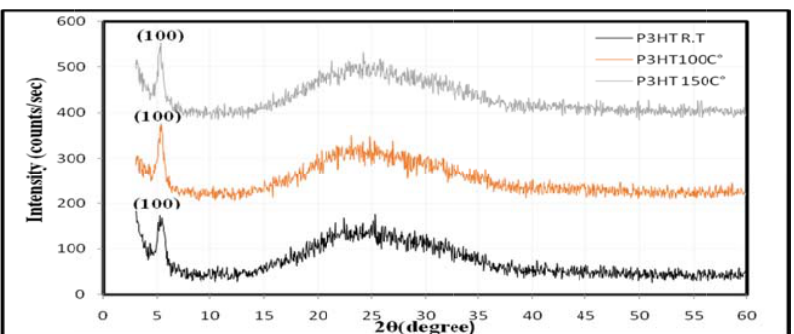
table, the pe P3HT:PC he P3HT.